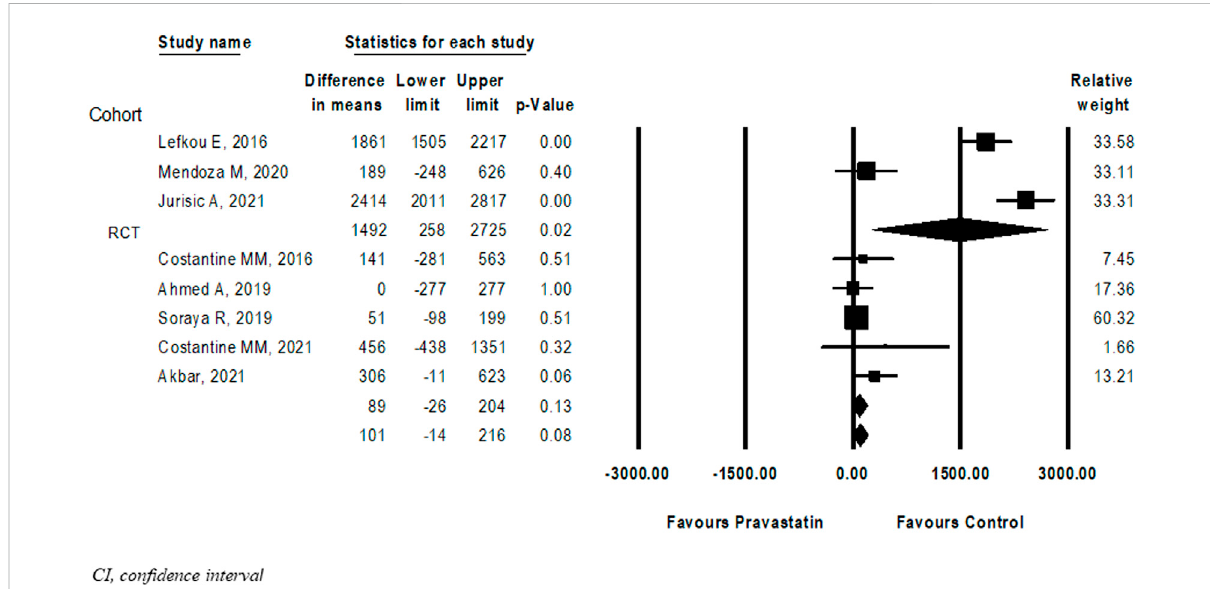
FIGURE 5 Meta-analysis results of the Differences in birth weight (grams) following pravastatin treatment versus a control group.